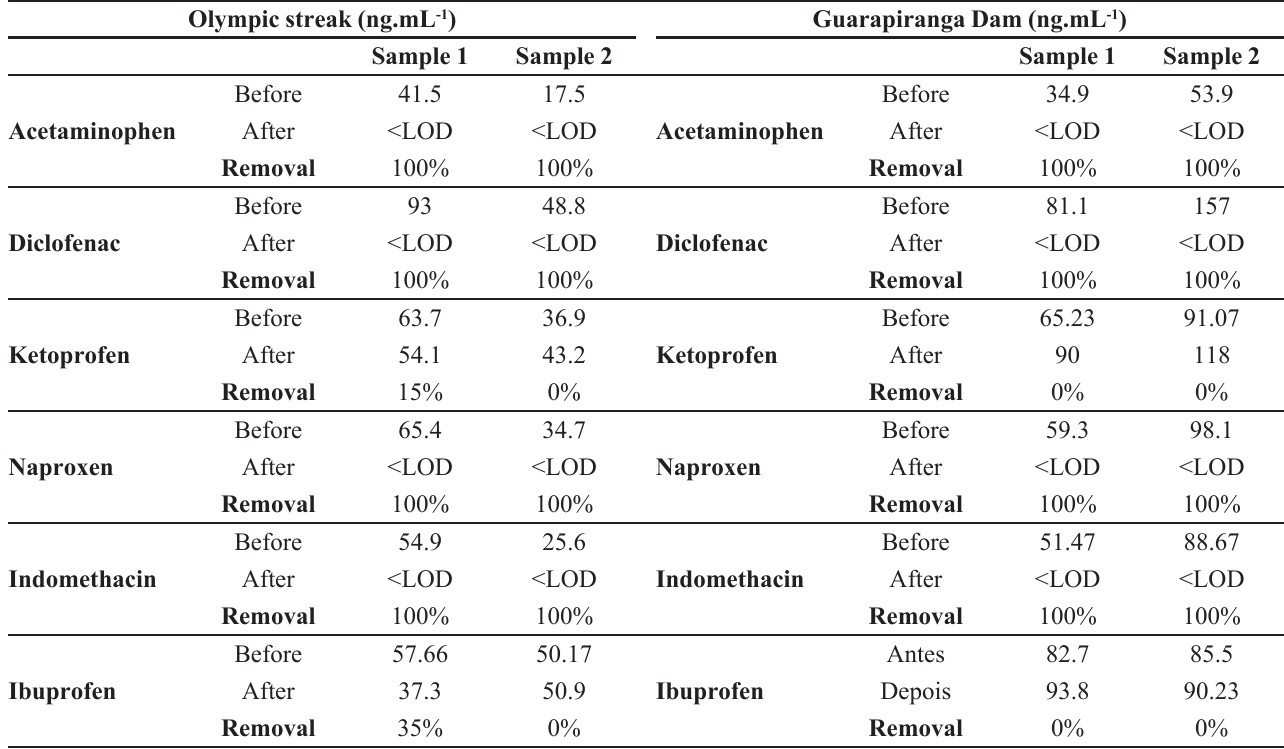
TABLE III - Mean values of concentration of analytes added before and after the jar test procedure (two samples of each compartment with known concentration) and removal percentage of each analyte in samples of USP Olympic Streak and Guarapiranga